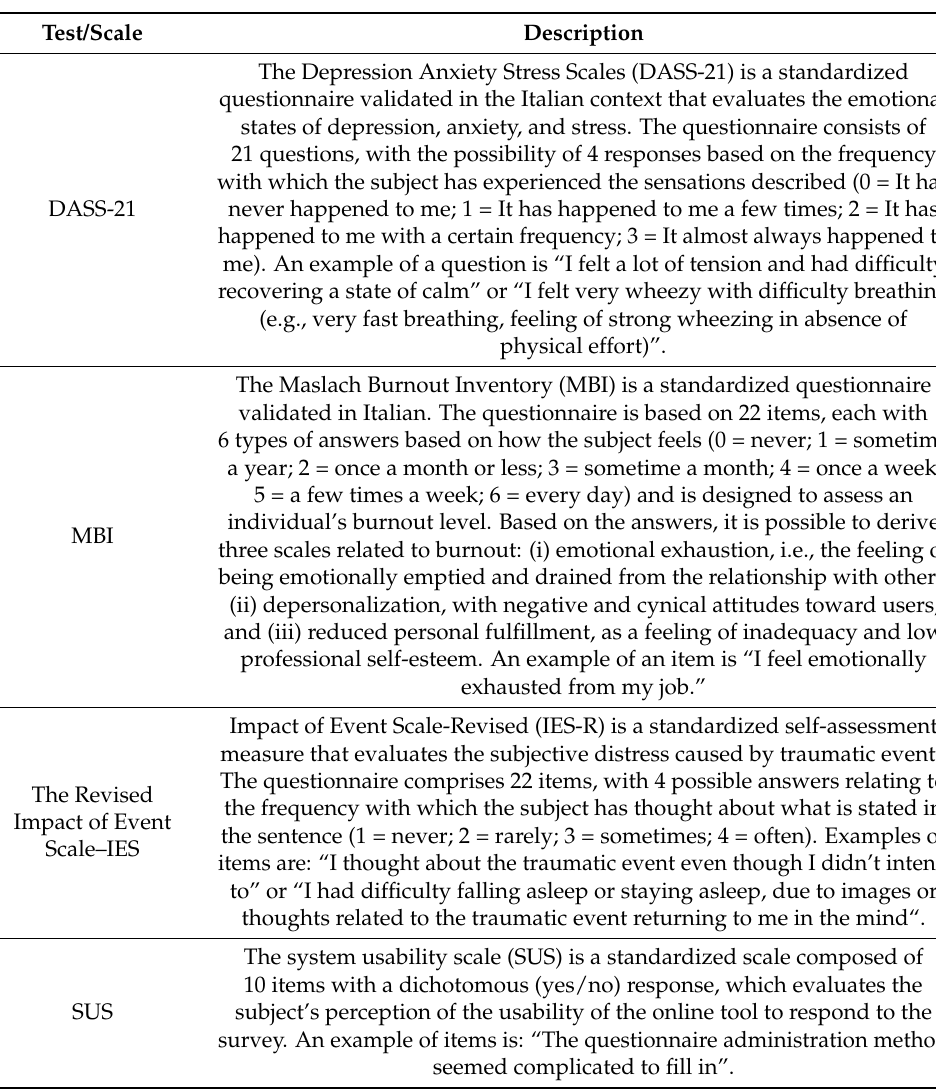
Table 2. Clinical assessment